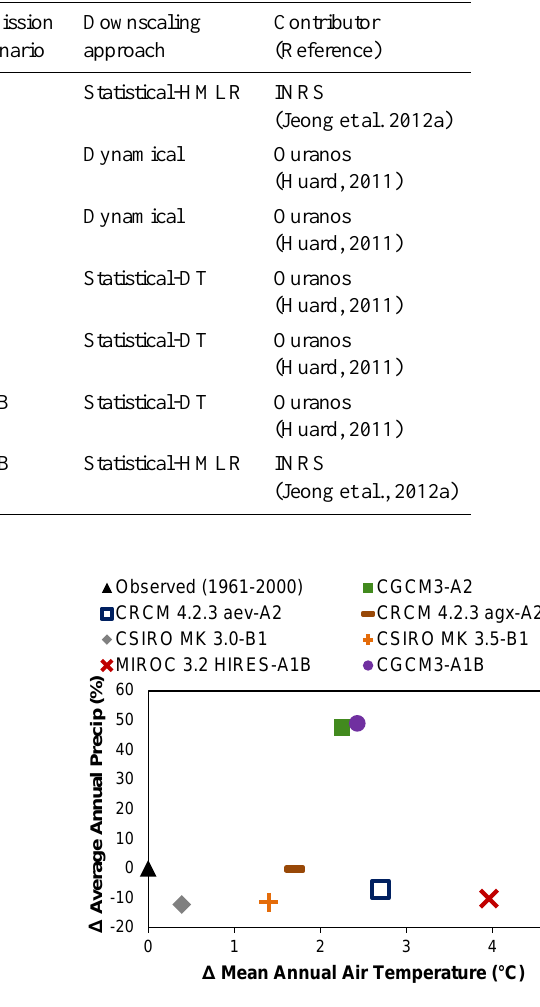
Table 1. Details for each of the seven climate scenarios employed in the current study.